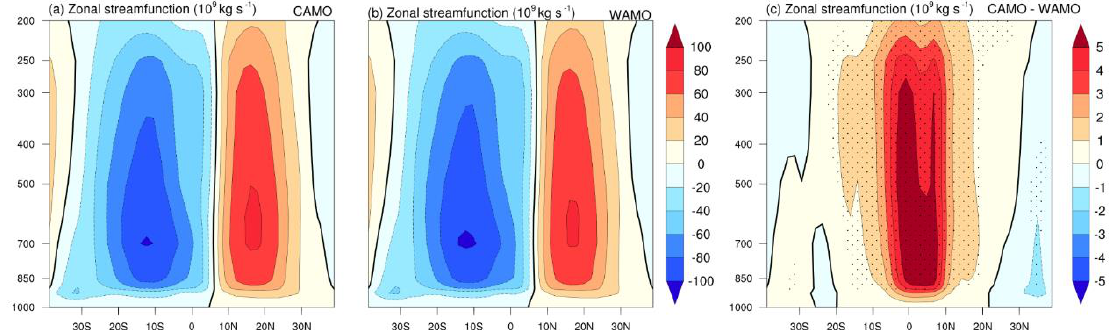
Figure 7. Climatological Hadley cell defined as the zonal mean stream function ψ (10 9 kg/s) for ( a ) CAMO, ( b ) WAMO and the differences between them ( c ). Red and blue contours (solid and dashed lines) denote clockwise and anti-clockwise mass stream functions. Black lines represent the zero-contour stream function. Stippled areas in ( c ) represent statistically significant (Stude nt’s t test at 95%) differences.